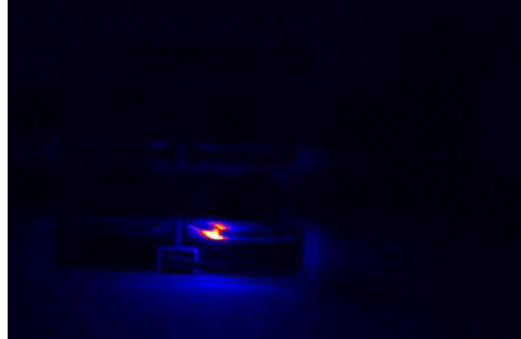
Fig. 5 . Amplitude image MOSFET transistor without thermal adjustment